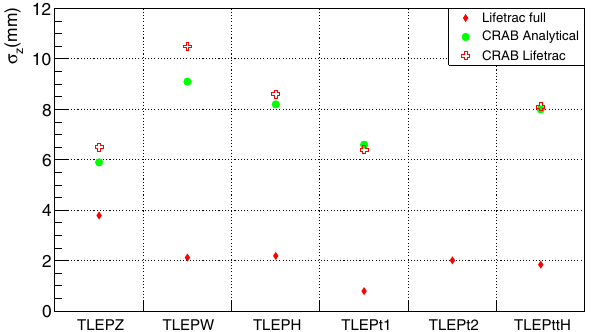
FIG. 8. Bunch length for different scenarios of TLEP operation. Red diamonds and red empty crosses are L IFETRAC simulations with full spectrum of beamstrahlung for Tables I and II, correspondingly; green dots are analytical calculations for the latter case. (Table I, red diamonds), crab analytical and crab L IFETRAC full are calculations (green dots) and simulations (red empty crosses) respectively, for the new set (Table II).